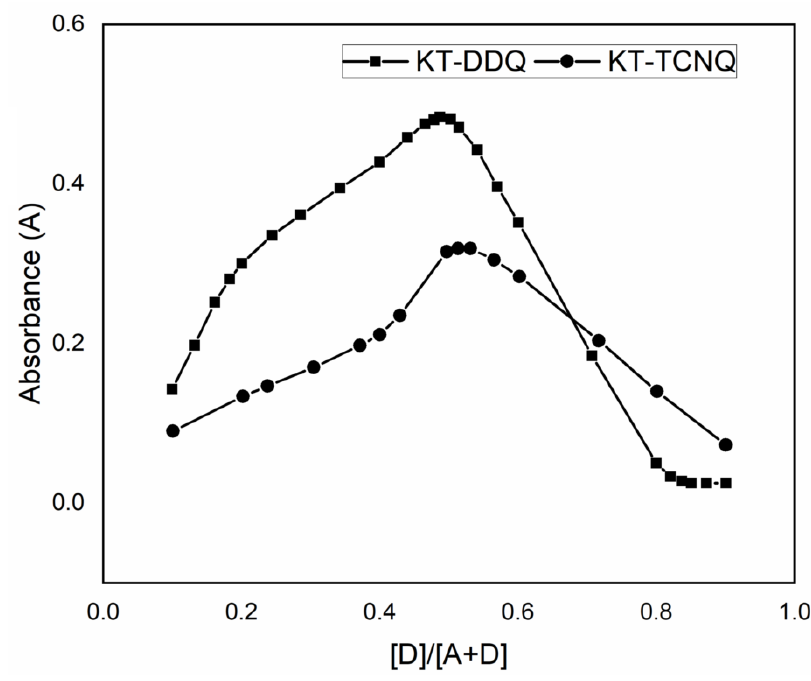
Table 1. Benesi–Hildebrand data for the KT–DDQ and KT–TCNQ complexes.